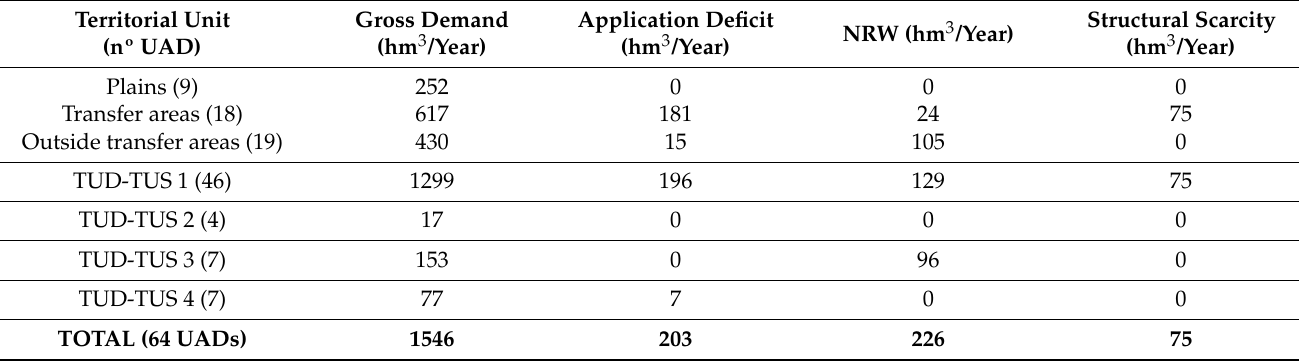
Table 10. Structural scarcity on the SRB. Source: own elaboration based on